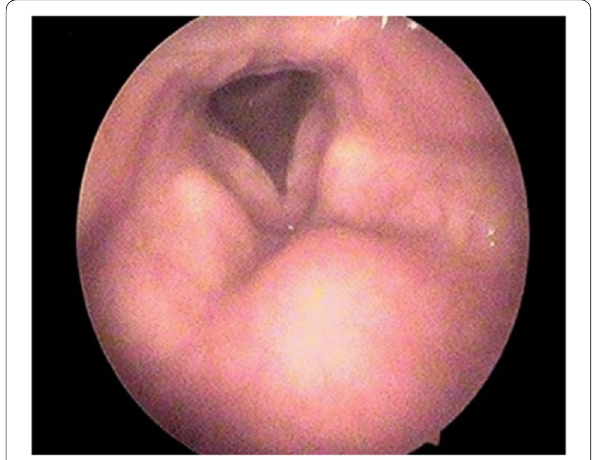
Fig. 3 Severe LPR showing edematous vestibular folds, arytenoids, and obliteration of ventricles as well as Reinke’s space edema of the bilateral vocal cords